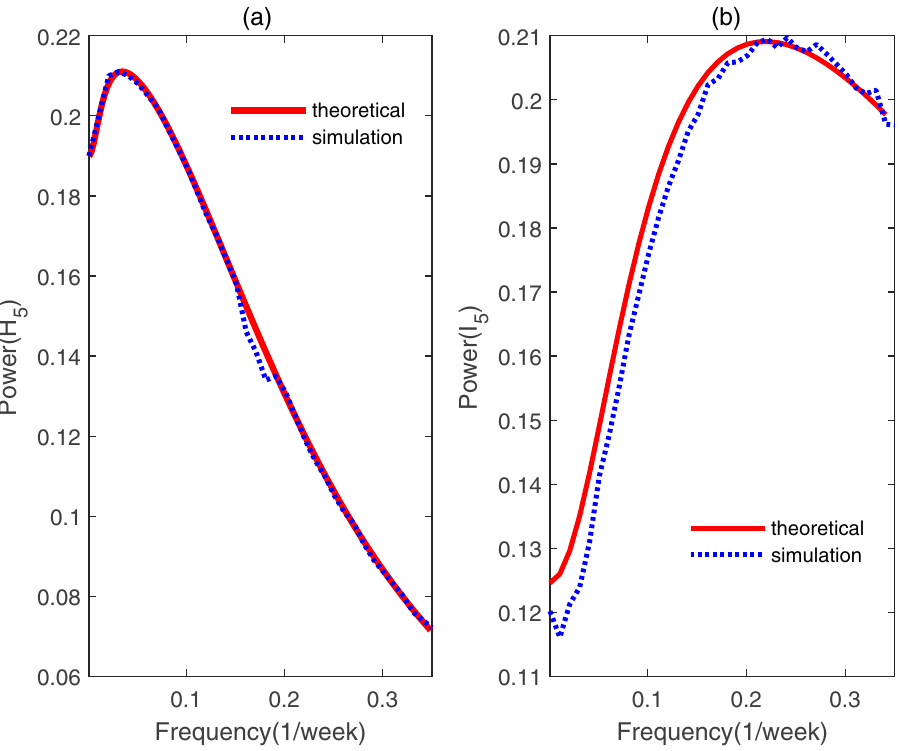
Figure 5. Comparisons between the theoretical prediction of PSD (21) and the average PSD obtained from the stochastic simulation, for the fluctuations of the infected with degree